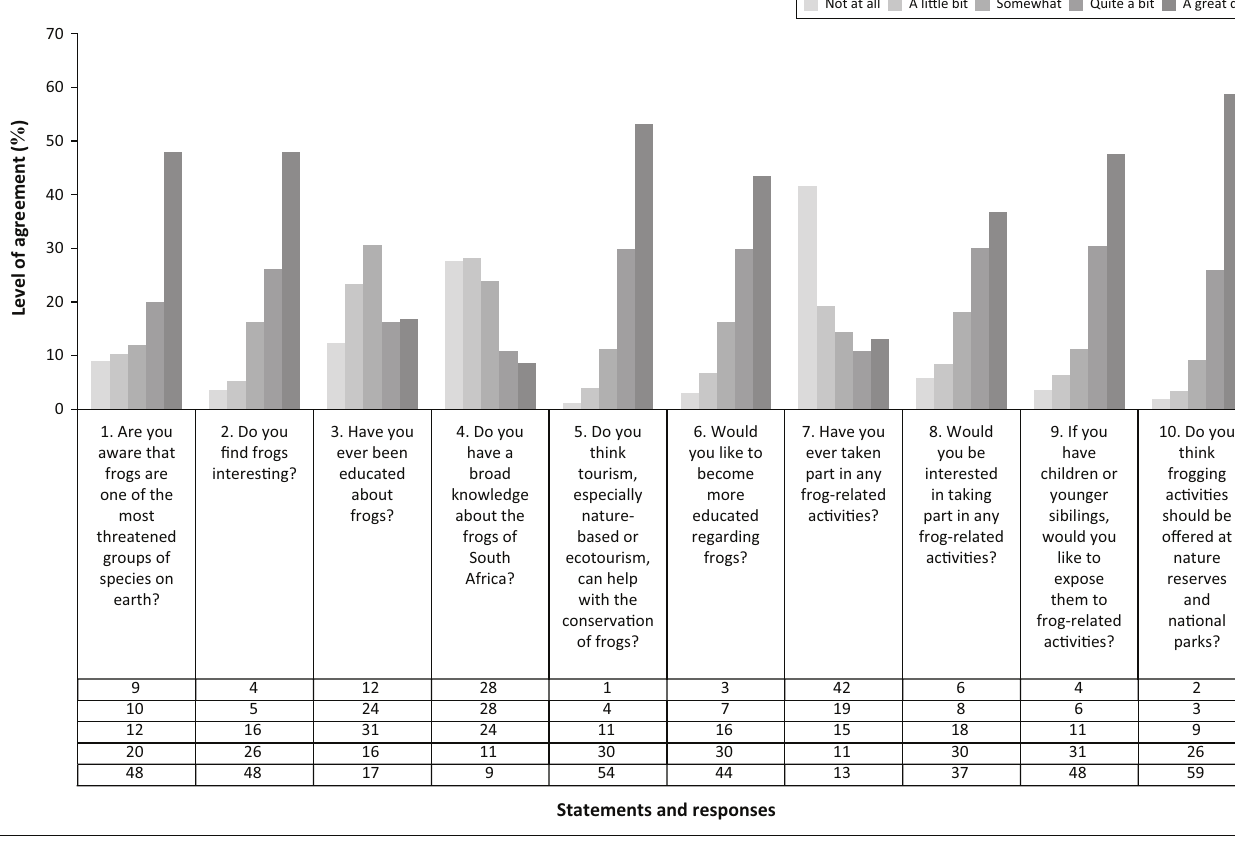
FIGURE 2: Respondents’ awareness and attitudes towards frogs.